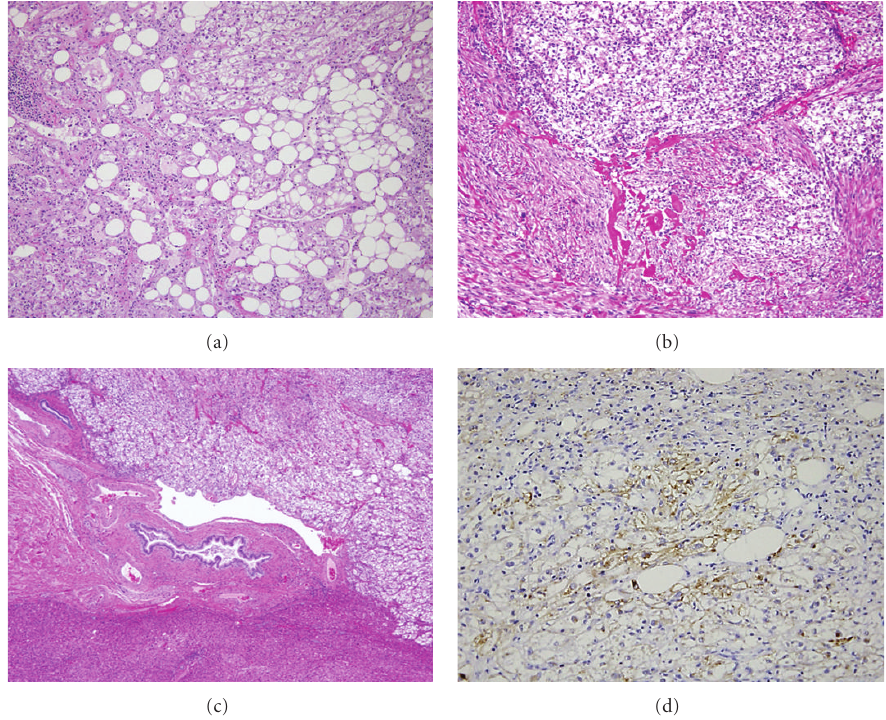
Figure 2: Pathological findings of HAML. The tumor was consisted of lipomatous, myomatous, and angiomatous tissue with variance. (a) A part of the tumor showed predominance of lipomatous tissue and the center of the tumor showed predominance of myomatous and angiomatous tissue (b). (c) The tumor showed aggressive growth pattern infiltrating into the portal vein (HE staining, × 40). (d) Tumor cells were positive for HMB-45 staining ( × 100) ((a) is from [12] with permission from